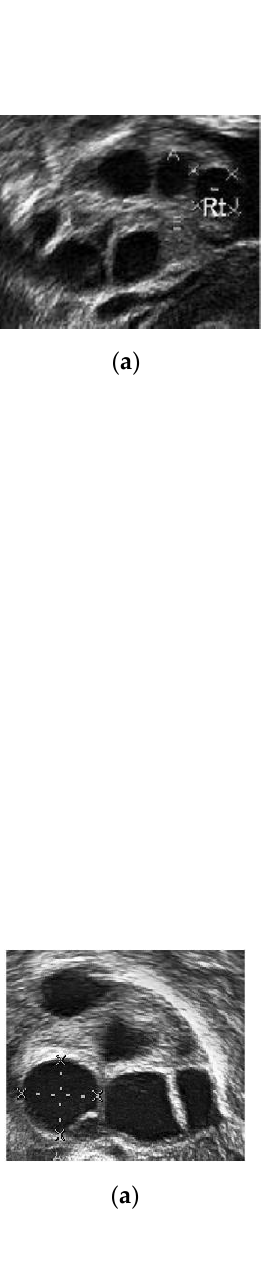
Figure 11. ( a ) Original ultrasound image, ( b ) ultrasound image after Otsu’s thresholding with a grayscale threshold level of 4.